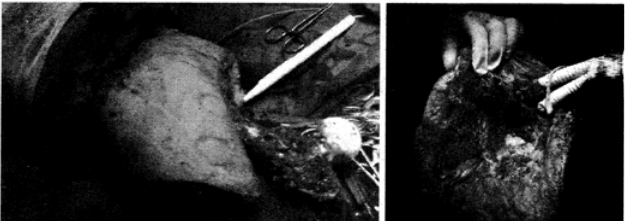
Figure 3a, 3b : Operative photographs showing disarticulation of left hip.